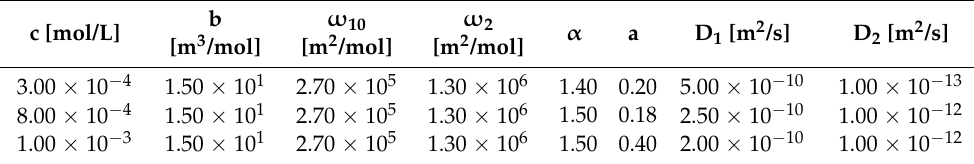
Table 11. Parameter values obtained by fitting the reorientation adsorption model Equations (4) and (5) and the diffusion Equation (6) to the experimental data of Figure 10 as measured for equimolar solutions of NaC 6 SO 4 + C 6